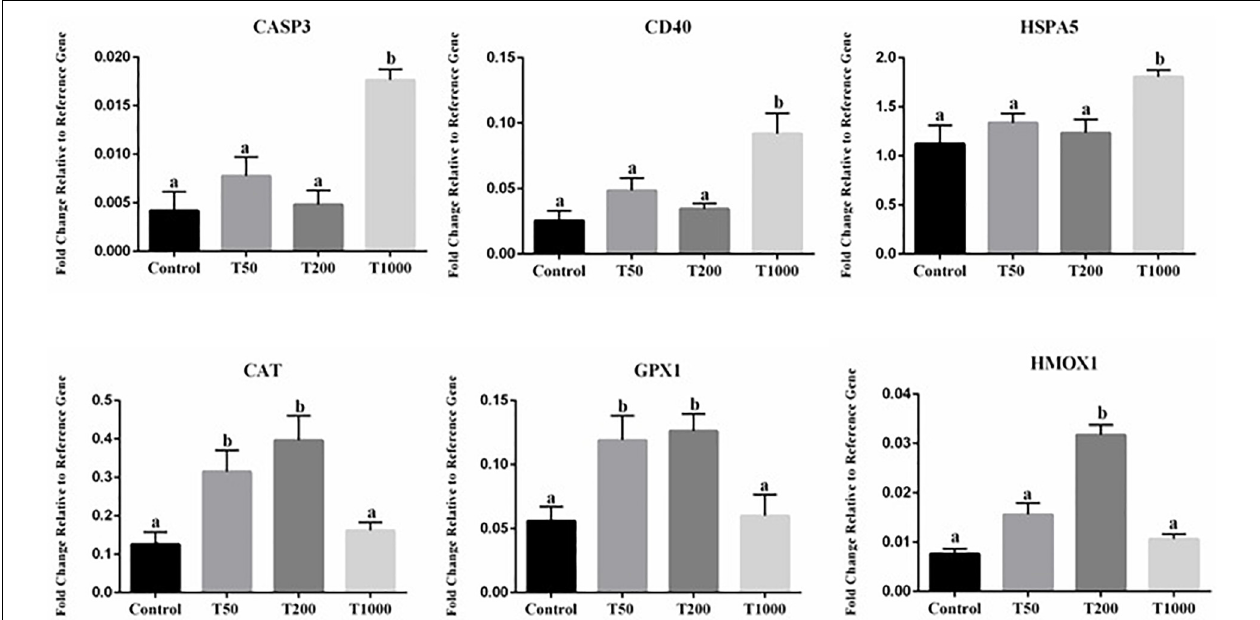
FIGURE 5 | Effect of TUDCA concentrations on differential gene expression in oocyte during IVM. Data represent the fold change in level of expression relative to the reference gene. Results are represented by least-squares means ± SEM of five replicates using 100 COCs/treatment. Different letters in each bar represent significant differences ( P ≤ 0.06). Control, 0 µ M TUDCA; T50, 50 µ M TUDCA; T200, 200 µ M TUDCA; T1000, 1,000 µ M TUDCA.